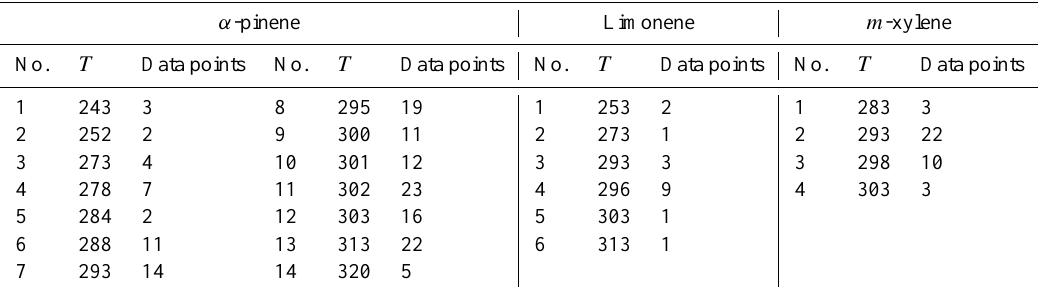
284 2 303 16 303 313 22 313 1